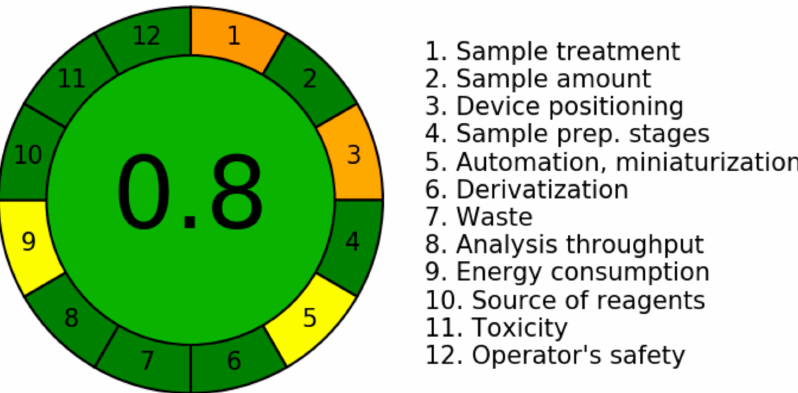
Figure 6. Representative diagram for AGREE scale for the green HPTLC method estimated utilizing “AGREE: The Analytical Greenness